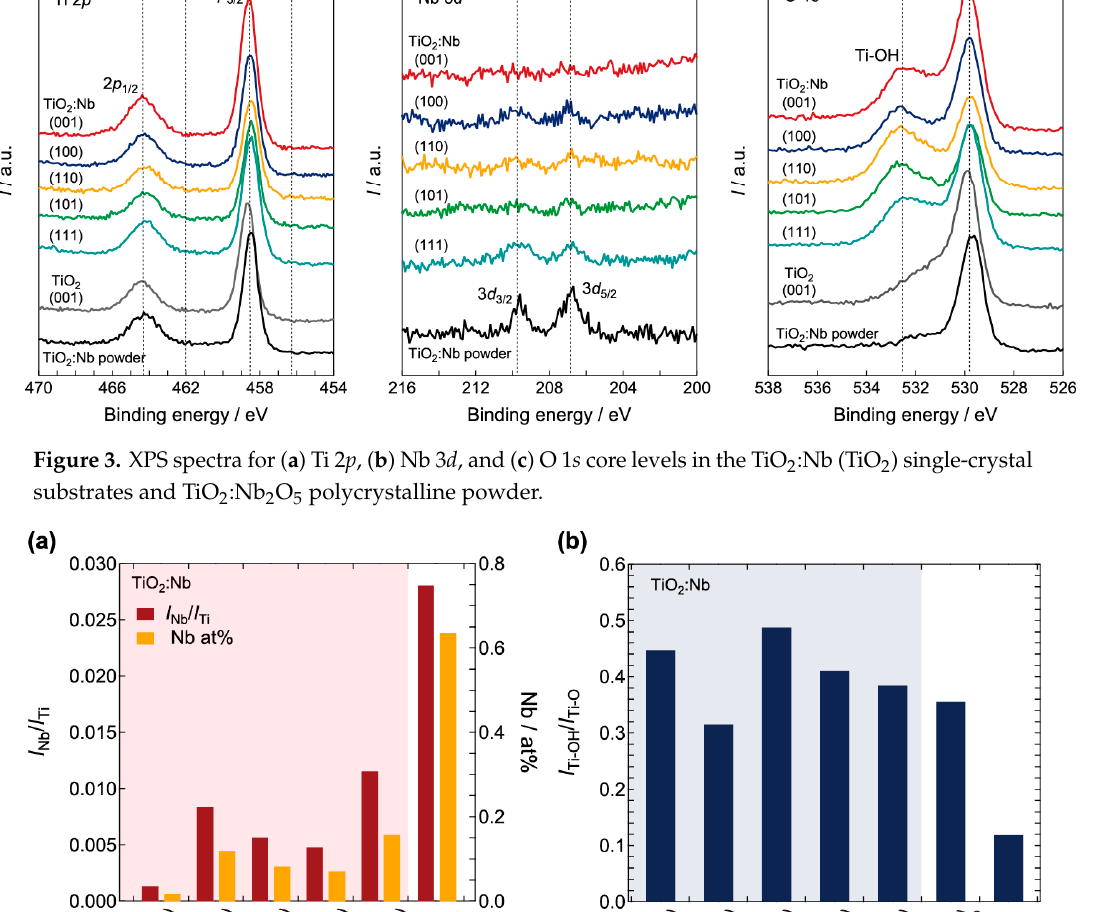
Figure 3. XPS spectra for ( a ) Ti 2 p , ( b ) Nb 3 d , and ( c ) O 1 s core levels in the TiO 2 :Nb (TiO 2 ) single- crystal substrates and TiO 2 :Nb 2 O 5 polycrystalline powder.